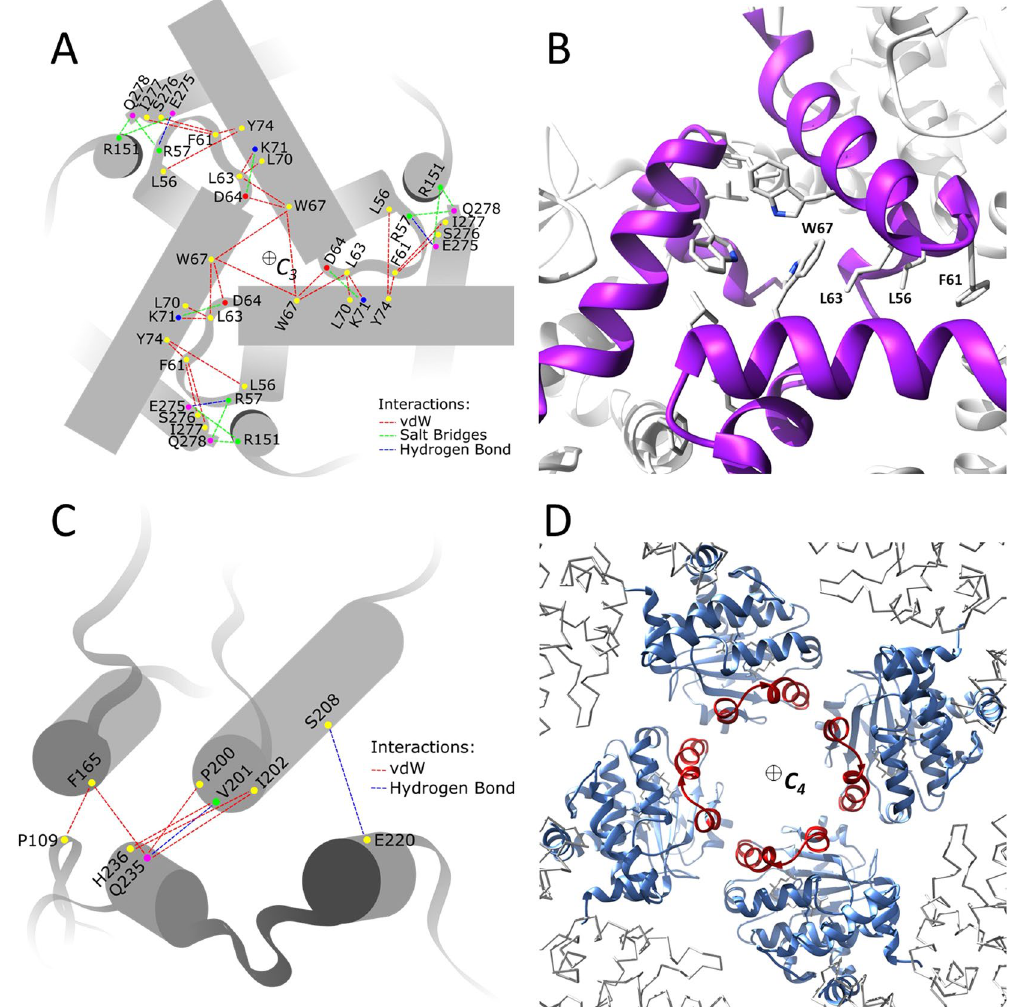
Figure 4. Schematic view of protein-protein interactions on the three-fold axis ( A ) and on the four-fold axis ( C ) (see Table 2 for details). ( B ) Close up view of the region around the three-fold axis. W67 forms a T-shaped van der Waals interaction with the adjacent homologs; this is the only point where a monomer interacts with two neighbours. The hydrophobic contact area of residues W67, L63, F61 and L56 defines a “hot-spot” motif in which binding energy is largely concentrated. ( D ) View from the interior along the C 4 axis; the mobile gate moieties are coloured red to emphasise the steric hindrance is interfering with the release of α